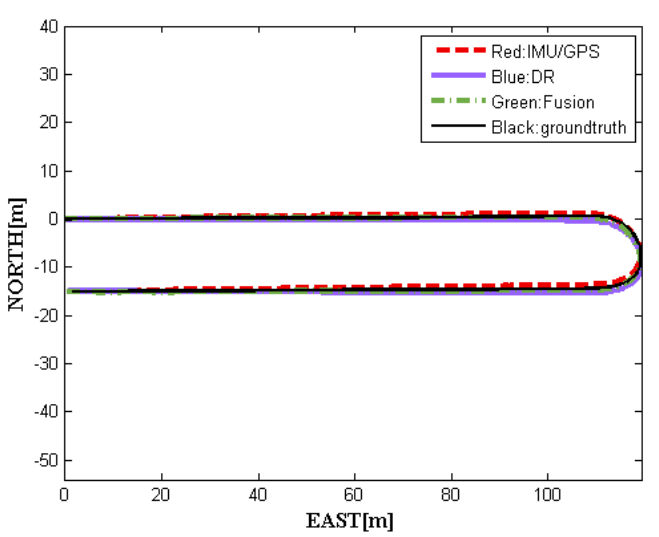
Figure 4. The four global trajectories recorded by vehicle.